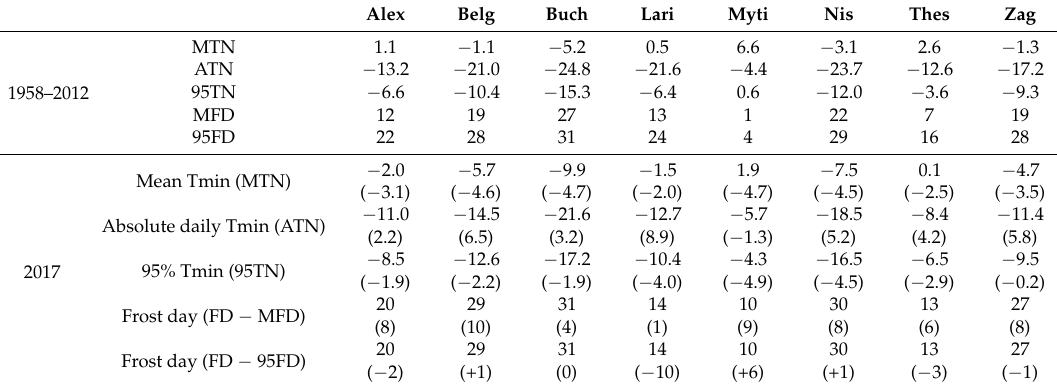
Table 2. January Minimum Temperature (TN) climatological characteristics for the 8 stations in the Balkan Peninsula. MTN: mean daily minimum temperature; ATN: Absolute daily minimum temperature; 95TN: the 95th percentile of minimum temperature; MFD: mean number of frost days pre year; 95FD: the 95th percentile of frost days. The number in parenthesis indicates the differences between the temperature in 2017 and the reference period.